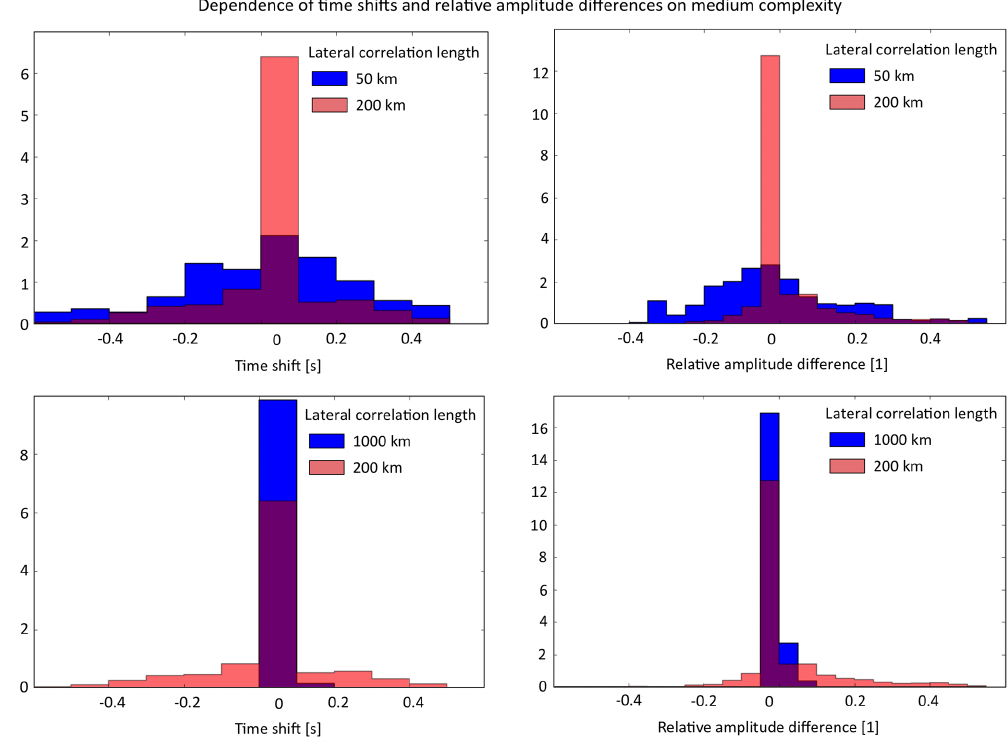
Figure 9. Histograms of time shifts (left) and relative amplitude differences (right) for a complex medium with 50km lateral correlation length (top, blue) and a smooth medium with 1000km lateral correlation length (bottom, blue). The medium with 200km lateral correlation length, used in the previous sections, is used as reference and plotted in magenta. The frequency band is 0 . 02–0 . 125Hz. Both time shifts and relative amplitude differences grow considerably with growing complexity of the